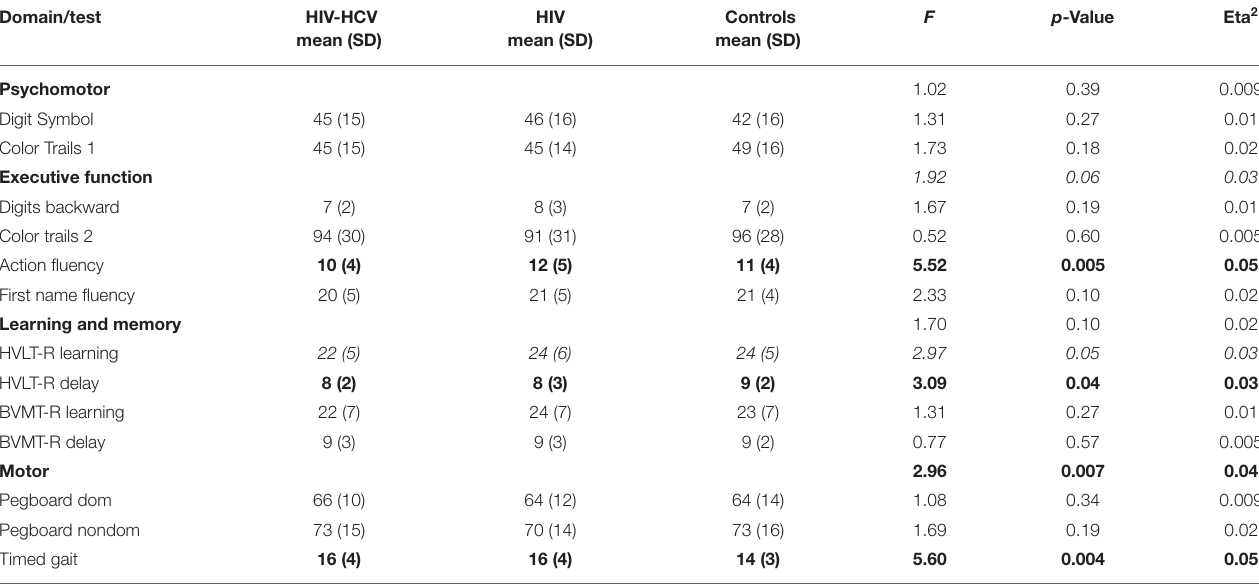
TABLE 2 | Baseline neurocognitive performance.